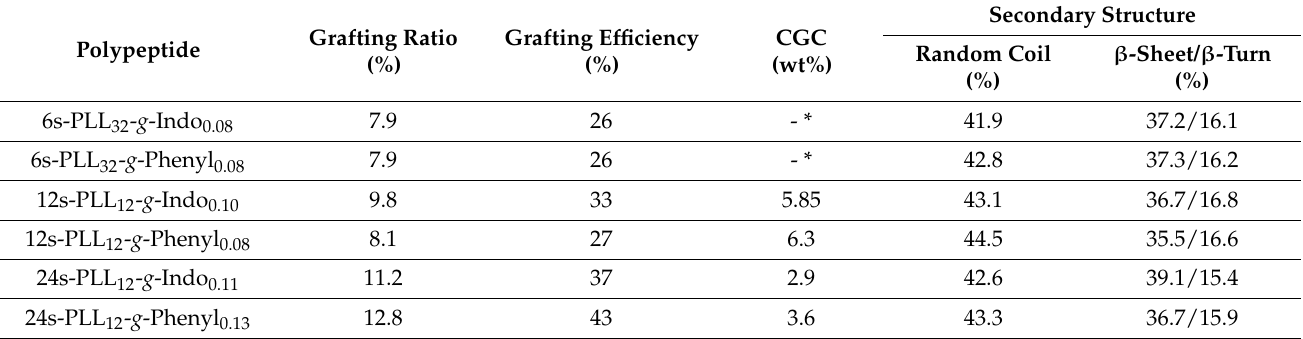
Table 1. The grafting ratio, grafting efficiency, critical gelation concentration (CGC) and the per- centages of various secondary conformations of star-shaped graft copolypeptides. The secondary structure data was fitted from the CD analysis using the BeStSel